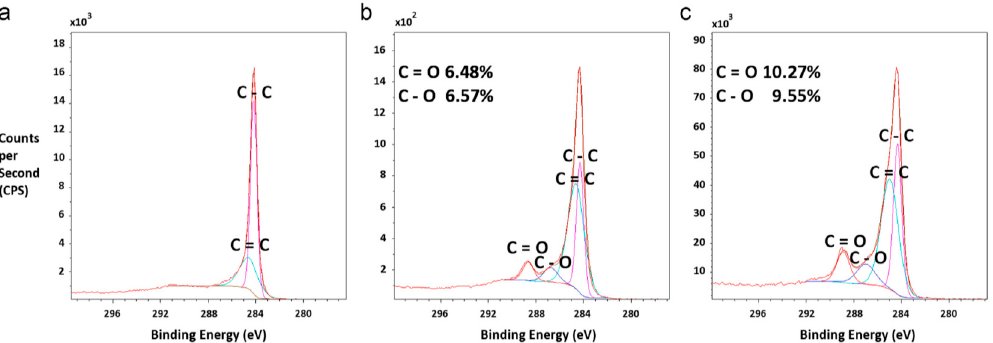
Figure 3. X-ray photoelectron spectroscopy (XPS) data showing the main carbon bonding (C–C) peak and the small peaks representing the carboxyl, hydroxyl, and carbene groups formed on the carbon nanotubes (CNTs). ( a ) Pure CNTs with no carboxylation show a lack of secondary and tertiary peaks about the main C–C bonding peak. ( b ) CNTs carboxylated to 6.53% show a small peak about the main carbon peak indicating single-and doubly-bonded carbon to oxygen (C–O and C = O). ( c ) CNTs that have been carboxylated to 9.91% demonstrate more prominent peaks about the C–O and C = O bonds. (Reproduced with permission after [32]).